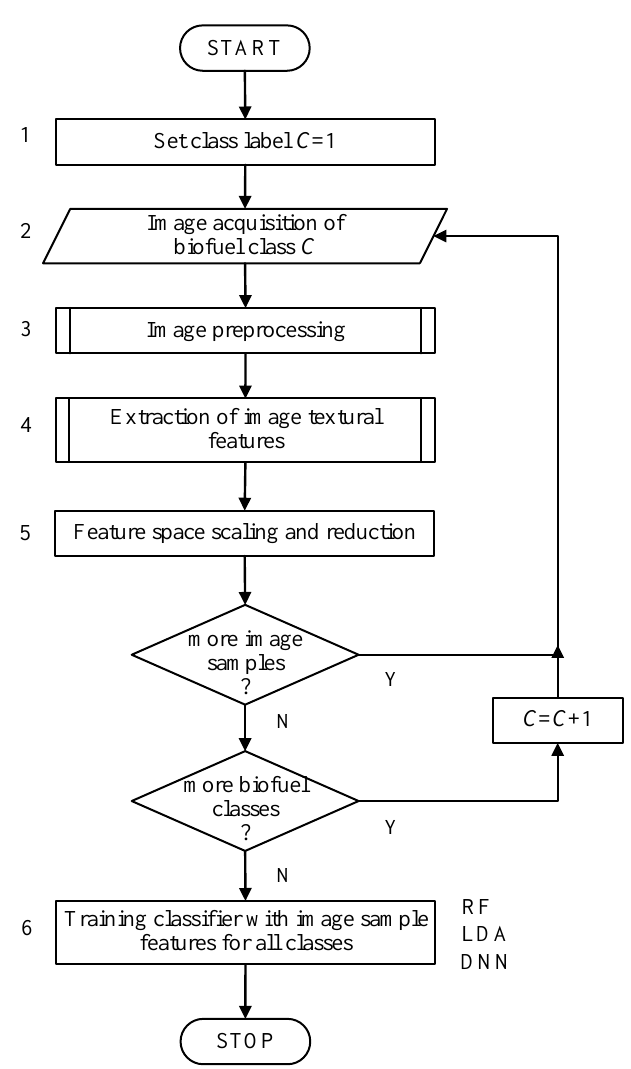
Figure 4. Flowchart of the algorithm in training mode: RF —random forest classifier; LDA —linear discrimination analysis; DNN —deep neural